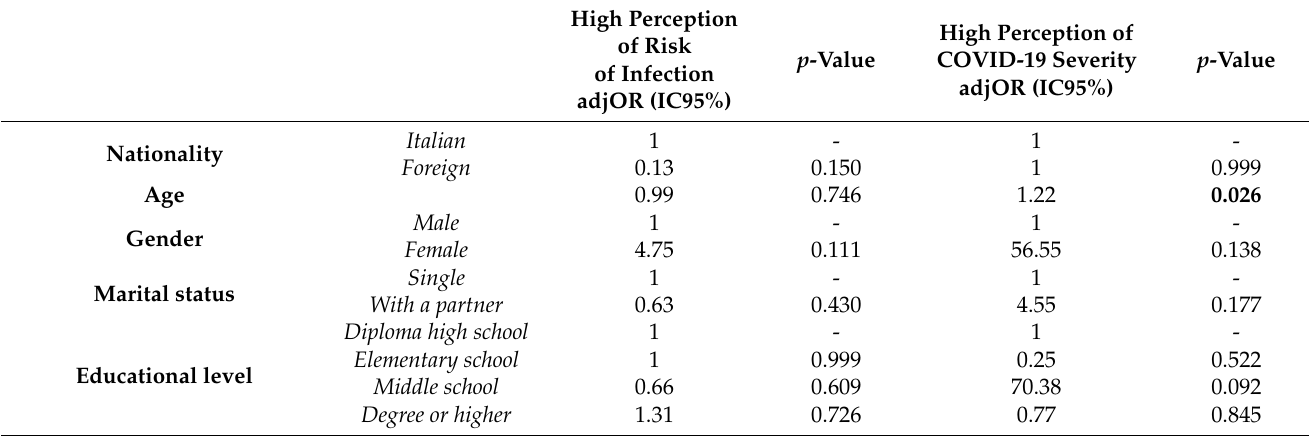
Table 4. Potential predictors of high perception of risk of infection and high perception of COVID severity (N = 160). High